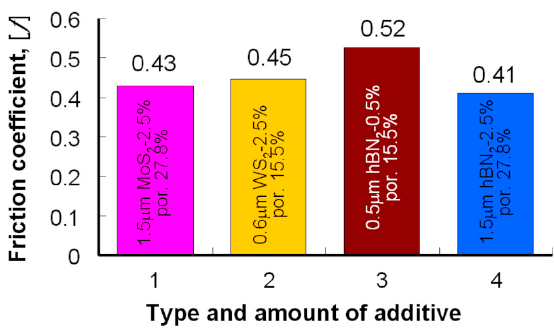
Figure 20. The lowest value of the friction coefficient obtained for individual additives.